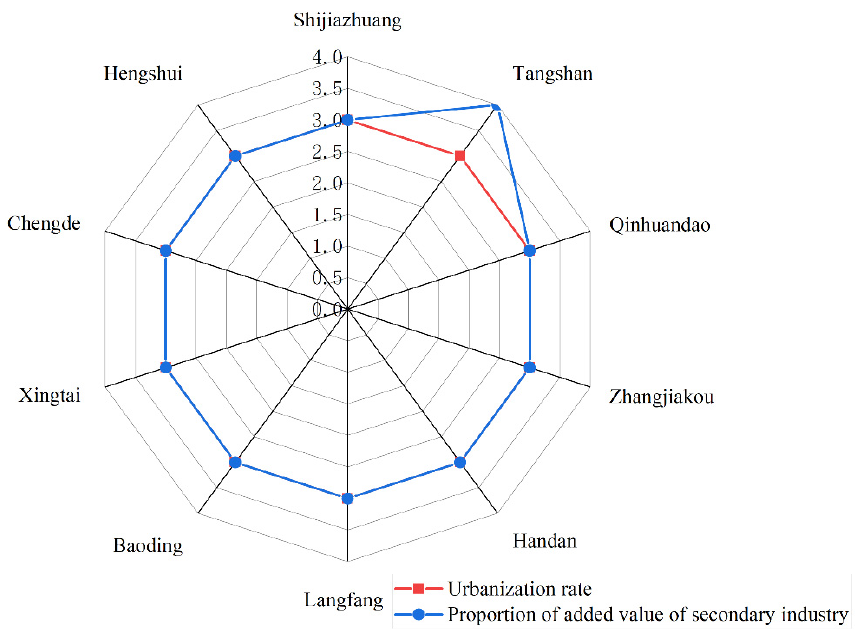
Figure 8. Spatial analysis chart of the proportion of urbanization rate and added value of the secondary industry in Hebei Province.